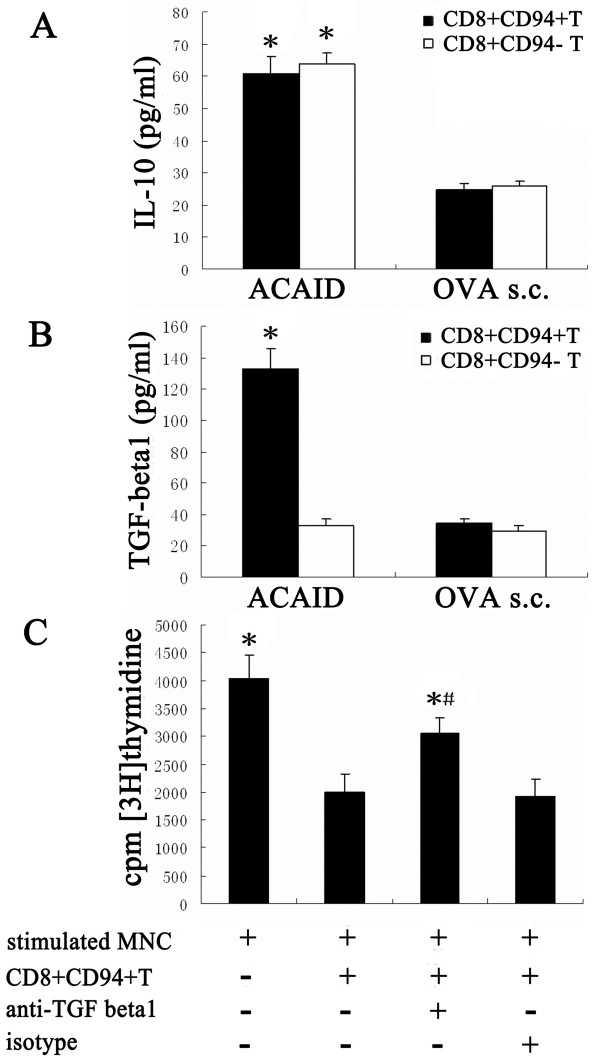
IL-10 and TGF-beta1 production and the role of TGF-beta1 in immunosuppression. CD8+CD94+T or CD8+CD94-T cells(5 × 104) from ACAID mice and immunized mice were cocultured with PEC(1 × 105) and OVA (100 μg/ml) for 72 hours. ELISA was used to detect the concentration of IL-10 (A) and TGF-beta1 (B) in the supernatants of the cultures. *p < 0.05 compared with immunized mice. For blocking experiments (C), anti-TGF-beta1 mAb(50 μg/ml) or matched isotype was added to the culture at the initiation of the cell proliferation assay, then [3H]thymidine incorporation was measured to value the suppressive activity of CD8+CD94+T cells from ACAID mice. Data are represented as mean ± SEM of triplicate samples. *p < 0.05 compared with stimulated MNC+CD8+CD94+T cell group (the second bar). #p < 0.05 compared with stimulated MNC group (the first bar).